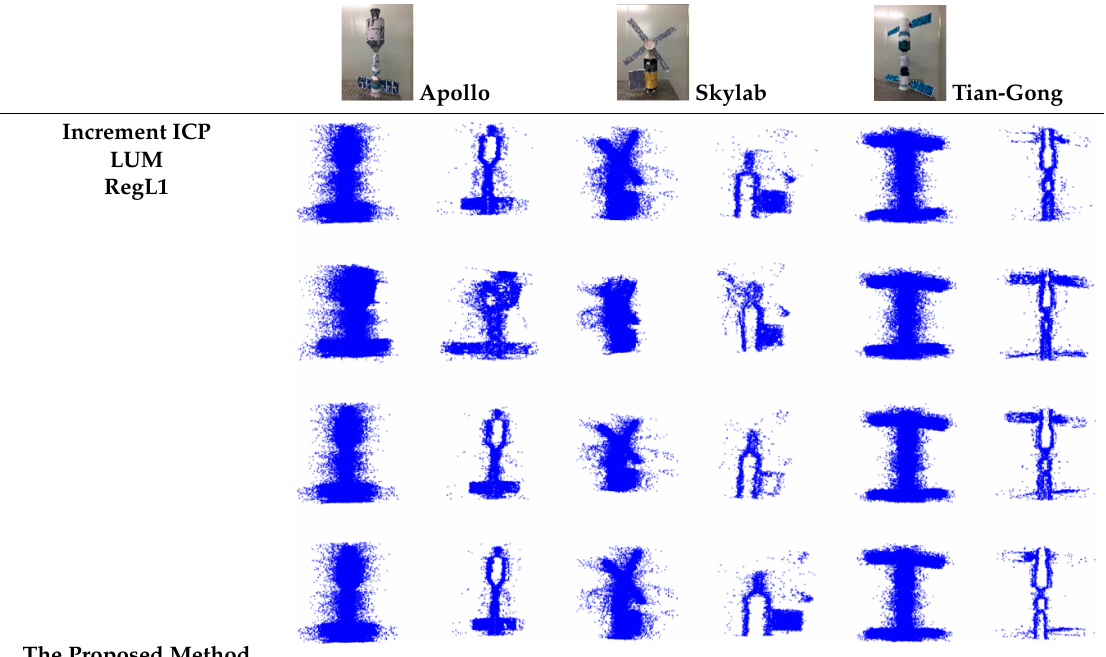
Table 2. The registration result with different methods on real point